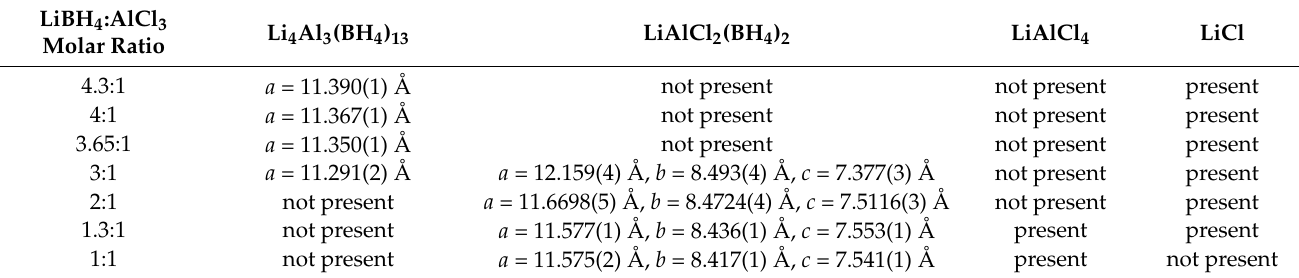
Table 1. Results of the phase analysis based on XRD data of the LiBH 4 –AlCl 3 system obtained after 3 h of ball milling of the mixtures with different molar ratios of the starting materials. Lattice parameters of LiAlCl 4 (Sp. Gr. P2 1 /c; a = 7.050(1) Å, b = 6.499(1) Å, c = 13.076(2) Å, β = 93.1(1) ◦ ) and LiCl (Sp. Gr. Fm-3m, a = 5.146(1) Å) are constant. Lattice parameters of stoichiometric Li 4 Al 3 (BH 4 ) 13 and LiAlCl 2 (BH 4 ) 2 are for the 4.3:1 and 2:1 reactions, all other represent Li 4 Al 3 (BH 4 ) 13-x Cl x and LiAlCl 2 ± y (BH 4 ) 2 ± y